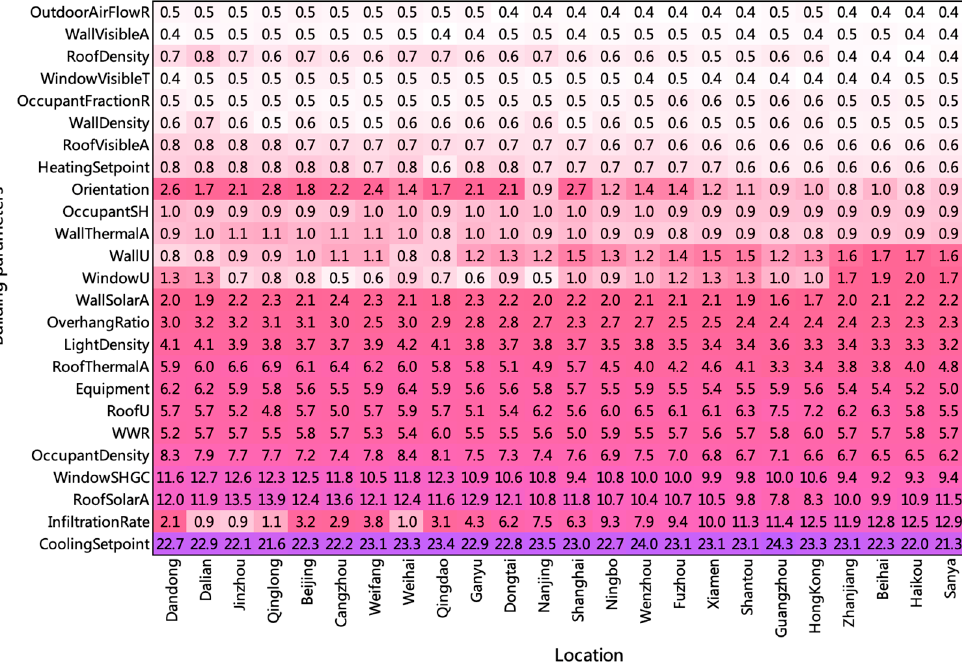
Figure 10. PI of input parameters in district cooling demand.